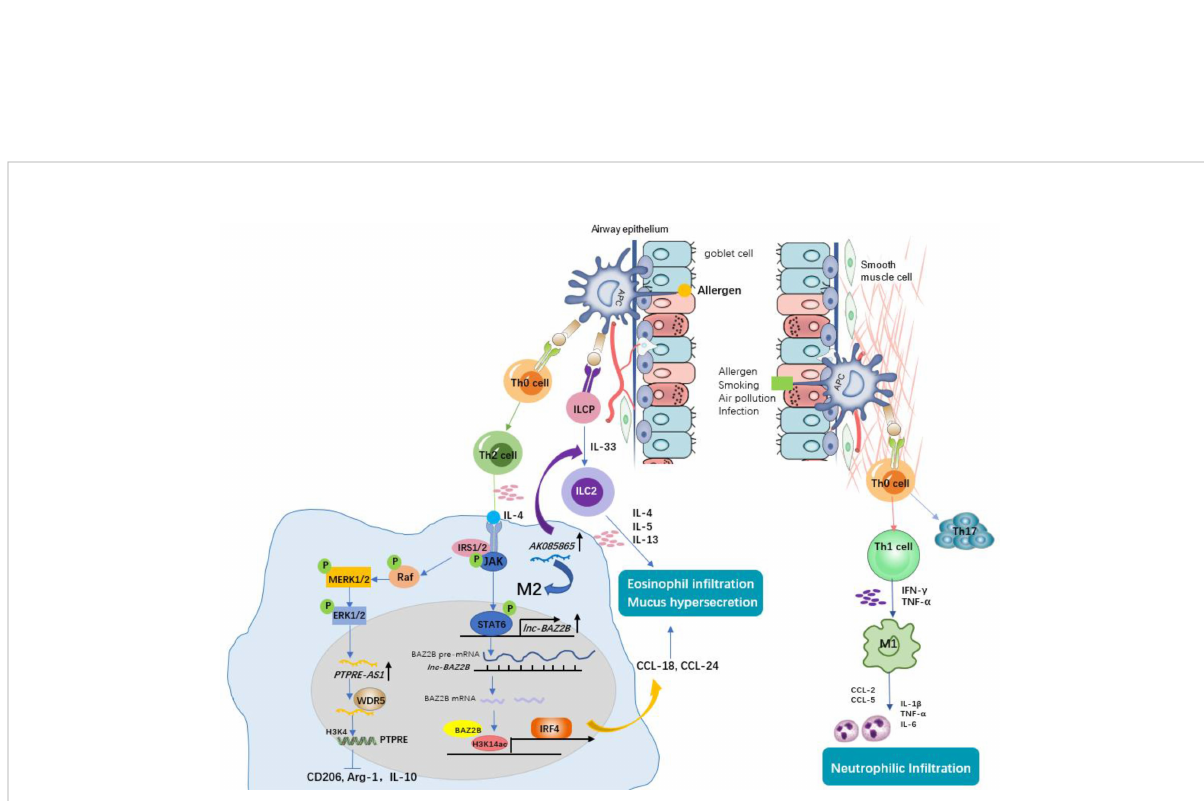
FIGURE 2 The role of macrophages and associated lncRNAs in allergic asthma. Antigen-presenting cells (APCs) identify allergens and initiate the allergic response. Under this condition, naïve CD4+ T cells differentiate into Th2 cells. Th2 cells secreting IL-4 induce M2 macrophage polarization. Lnc-BAZ2B promotes M2 macrophage activation by stabilizing BAZ2B pre-mRNA, thereby promoting IRF4 expression and chemokines secretion, leading to mucus hypersecretion and eosinophil in fi ltration in allergic children. PTPRE-AS1 is selectively expressed in IL-4 – stimulated M2 macrophages. PTPRE-AS1 binds WDR5 directly, modulating H3K4me3 of the PTPRE promoter to regulate PTPRE-dependent signaling during M2 macrophage activation and protects against pulmonary allergic in fl ammation. LncRNA AK085865 promotes M2 macrophages activation and M2 macrophages promote the differentiation of innate lymphoid cells progenitor (ILCP) into type II innate lymphoid cells (ILC2s), thus aggravate Type 2 immune response. Non-Th2 asthma (i.e., neutrophilic asthma), by contrast, is driven by M1 macrophages or Th1/Th17 lymphocytes through the production of high levels of proin fl ammatory Th1 cytokines (e.g., IL-6, IL-1 b , and TNF- a ) and chemokines (e.g., CCL2 and CCL5), contributing to neutrophilic in fi ltration and airway in fl